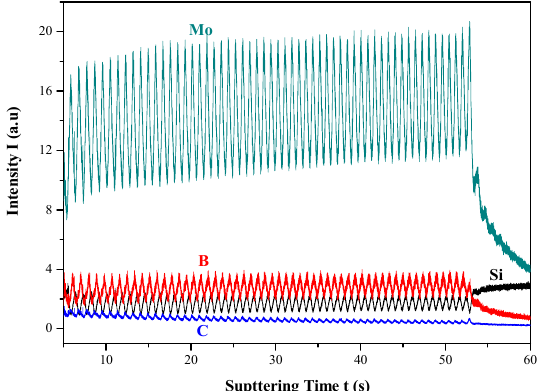
Figure 5. The measured GDOES depth profile of the Mo/B 4 C/Si nano-multilayer. Clearly, the measured GDOES depth profile of 60 × Mo (3 nm)/B 4 C (0.3 nm)/Si (3.7